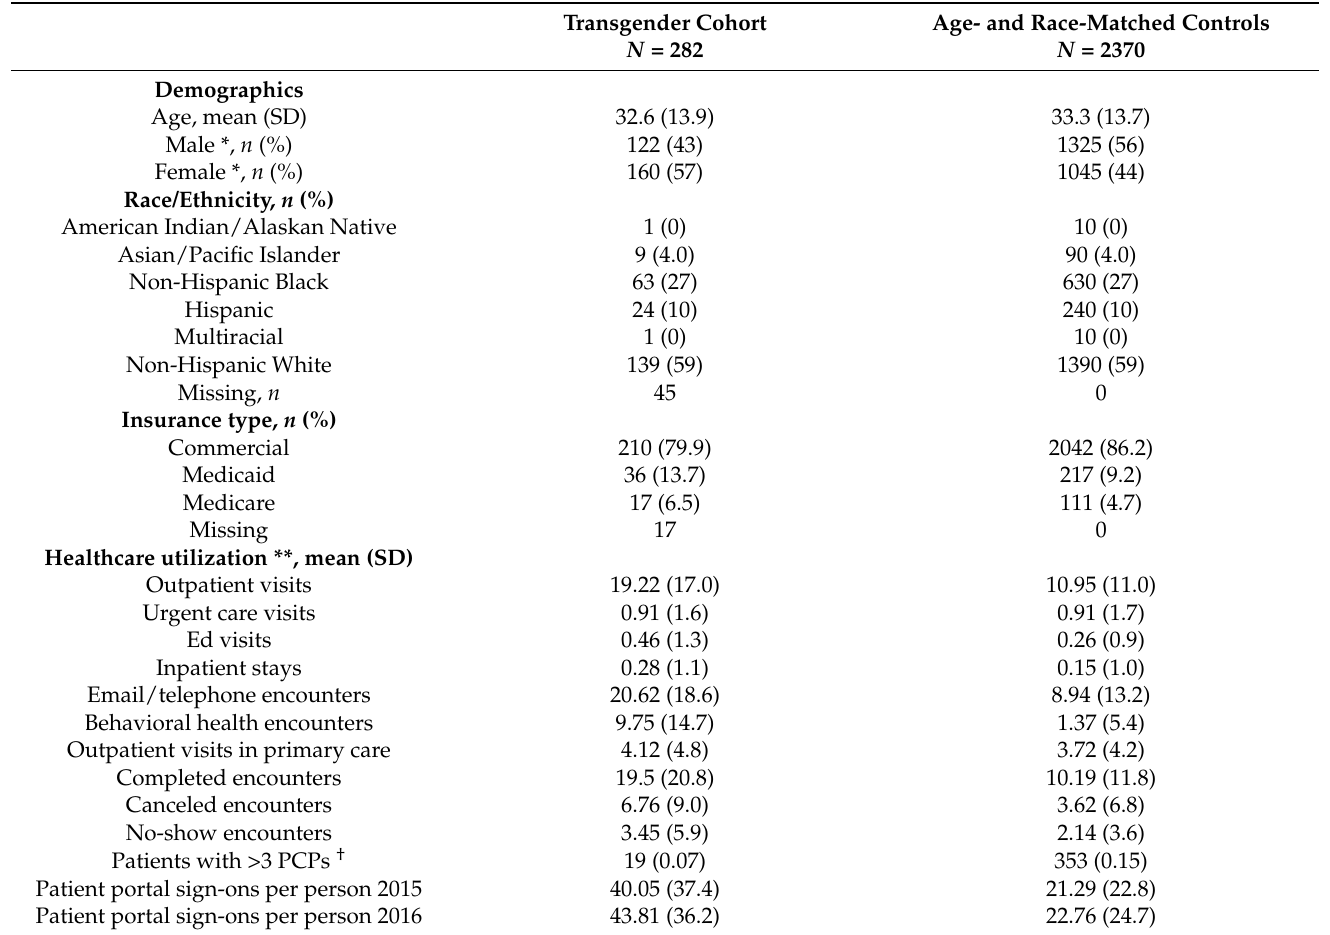
Table 1. Characteristics of transgender patients age- and race-matched